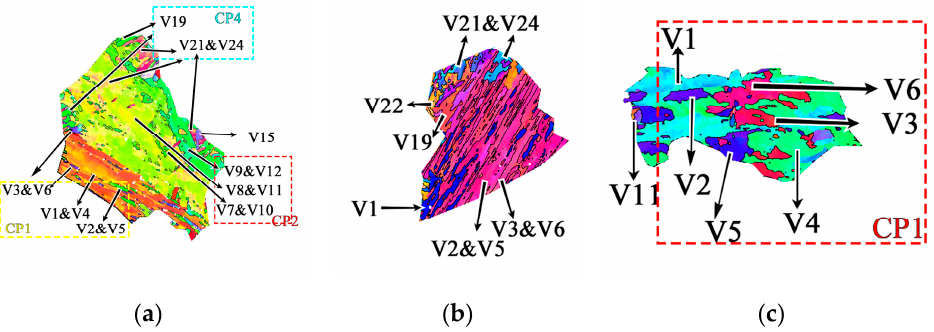
Figure 9. IPF maps showing variants feature within prior austenite grains reconstructed at the position of ( a ) 10 mm, ( b ) 30 mm and ( c ) 60 mm.